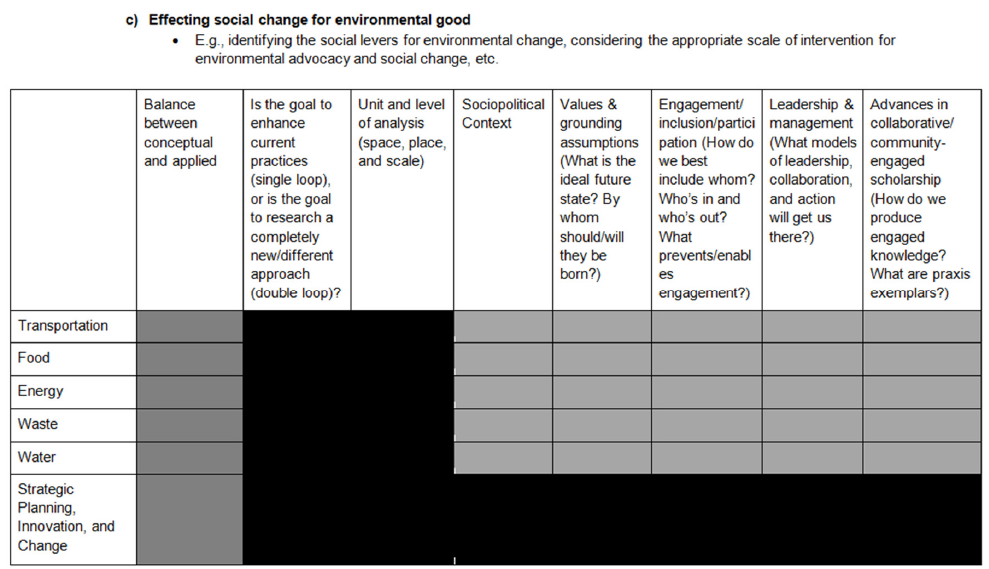
Figure 2. Framework tool for theme (c) Effecting social change for environmental good. Darkest cells represent intersecting research foci with most potential (see text above for further explanation).